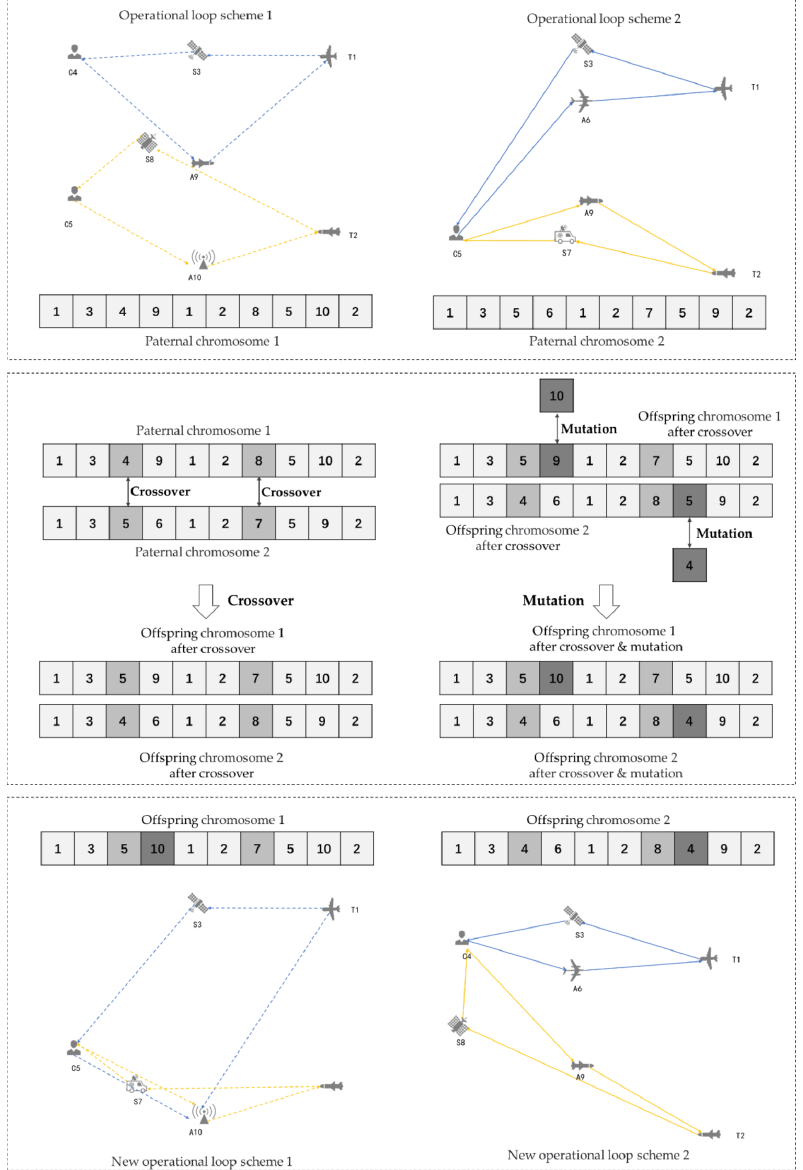
Figure 5. Crossover and mutation operations in the operation loop decision-making problem.